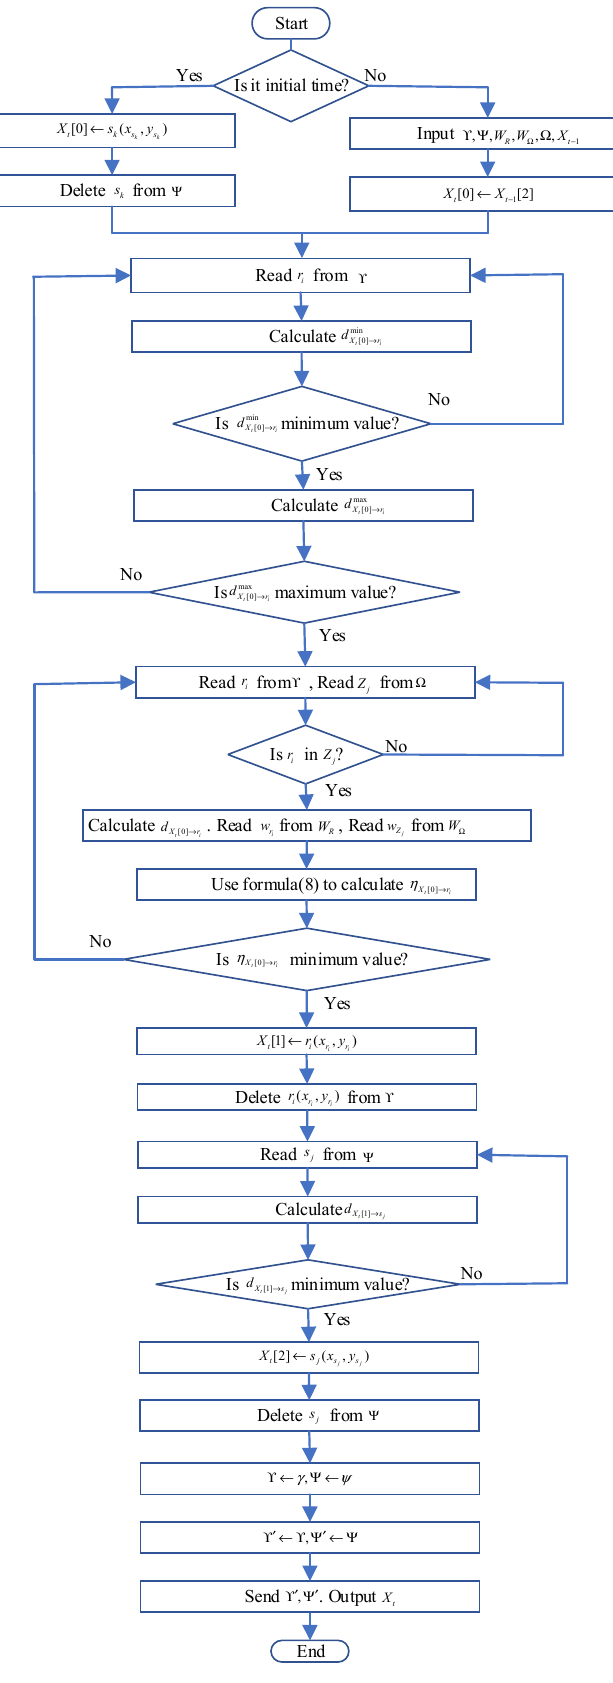
Figure 4. Tow-step path planning process of robot-trailer.